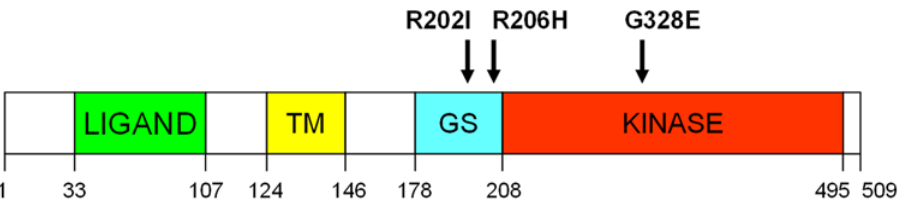
Figure 2. A schematic of ACVR1 domain organization showing the position of mutations in patients 1 (Arg202Ile) and 2 (Gly328Glu) with respect to the classical mutation (Arg206His).